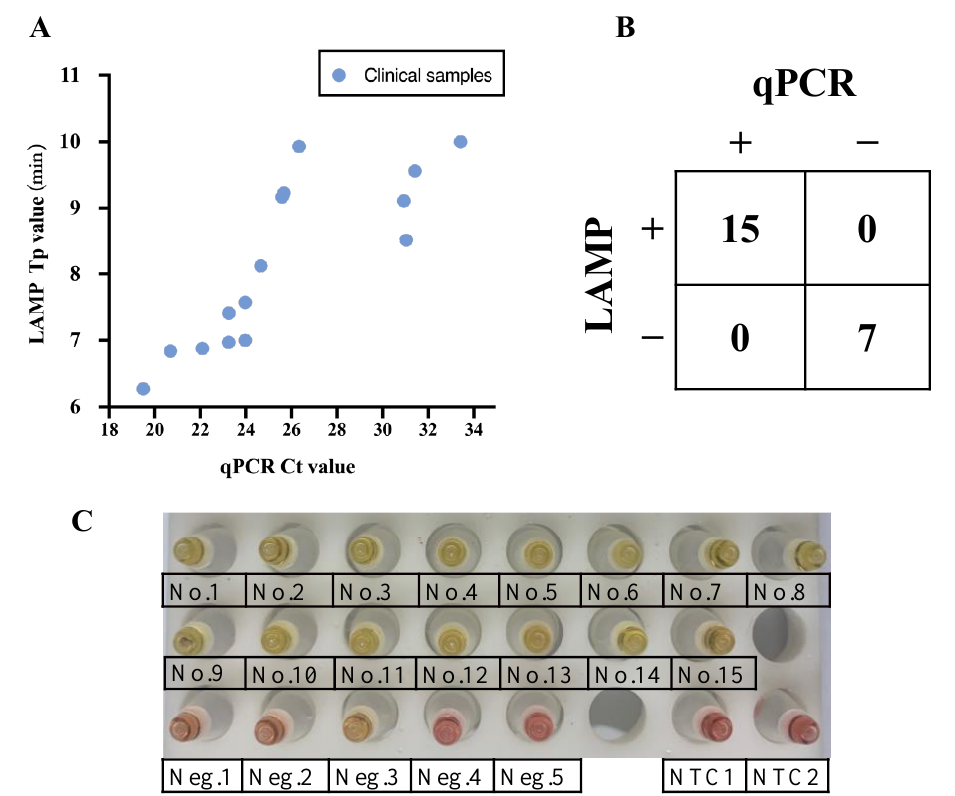
Figure 4. Clinical validation of the mpox LAMP using extracted DNA from fifteen biological samples (five crusts, nine pus, one serum), five healthy serum samples and two non-template controls (NTC). ( A ) Scatter plot of the Tp (time to positive) values of the fluorescent LAMP and the Ct values of the real-time qPCR assay on biological samples. ( B ) Concordance between the fluorescent LAMP assay and qPCR for clinical samples. ( C ) Clinical validation of the visual LAMP was visualized after incubation for 60 min by naked eye.